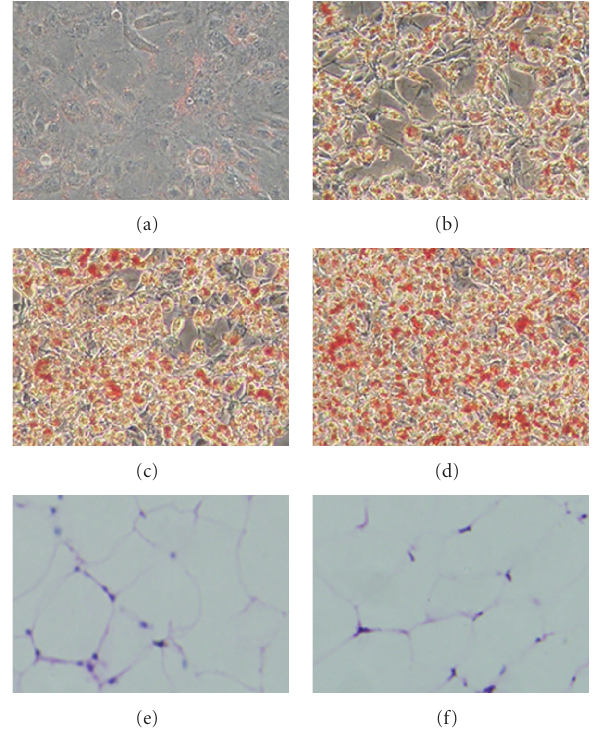
Figure 2: CE promoted 3T3-L1 adipocyte di ff erentiation. 3T3-L1 cells were stained with oil red O at day 5. (a) Undi ff erentiated control cells; (b) DM (insulin 10 μ g/mL, dexam: 1 μ M, IBMX: 0.5 mM)-induced di ff erentiated cells; (c) DM-induced di ff erenti- ated cells + CE 0.2mg/mL; (d) DM-induced di ff erentiated cells + CE 0.6mg/mL; (e) HE staining of WAT from high-fat diet